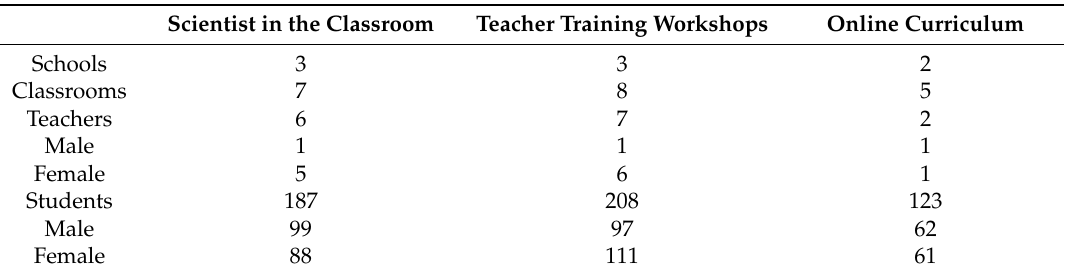
Table 1. Demographic information for student and teacher participants in each